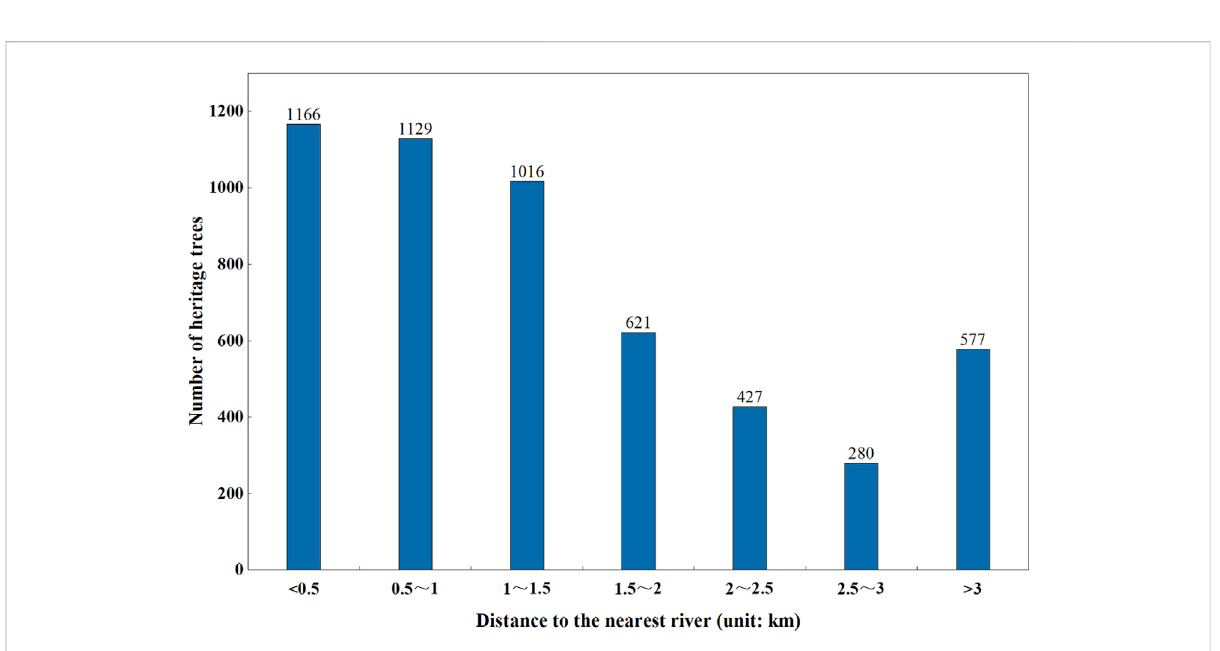
FIGURE 7 Number of heritage trees in different distances to the nearest